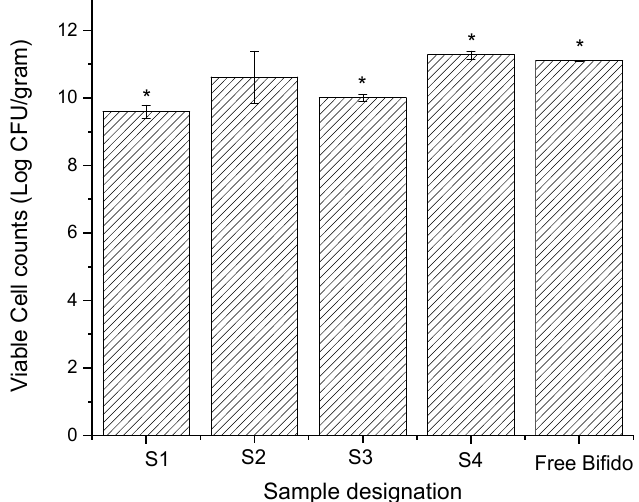
Figure 6. Viable cell counts post-encapsulation of Bifido probiotic cells encapsulated within electrosprayed ETC core-shell microcapsules and non-encapsulated (free) Bifido. All values are mean ± standard deviation, and * indicates a significant difference ( p < 0.05).